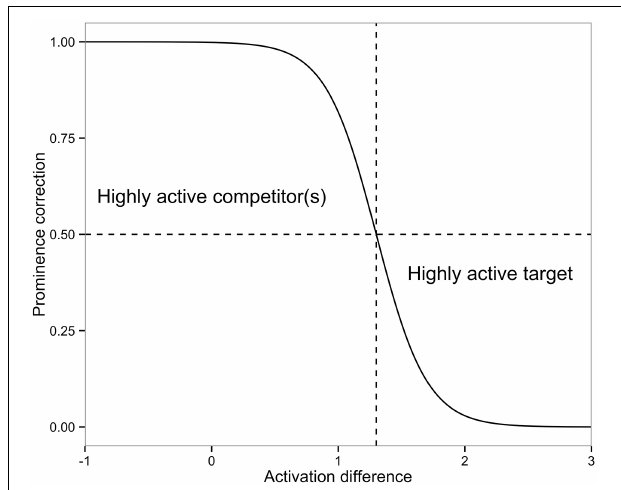
FIGURE 1 | Prominence correction by activation difference Diff (target − distractors) with C = 5 and x 0 = 1 . 3 .